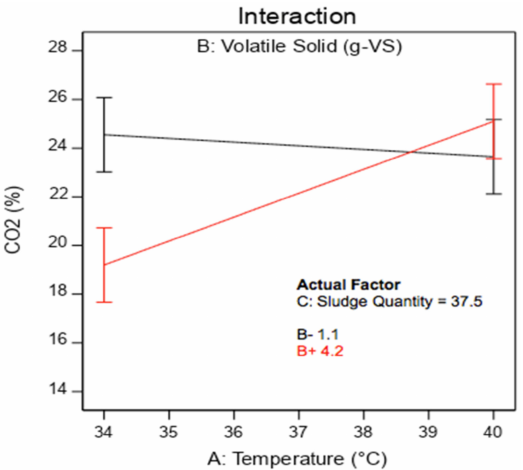
Figure 33. Interaction Plot views the effect of interaction between temperature and volatile solid on CO 2